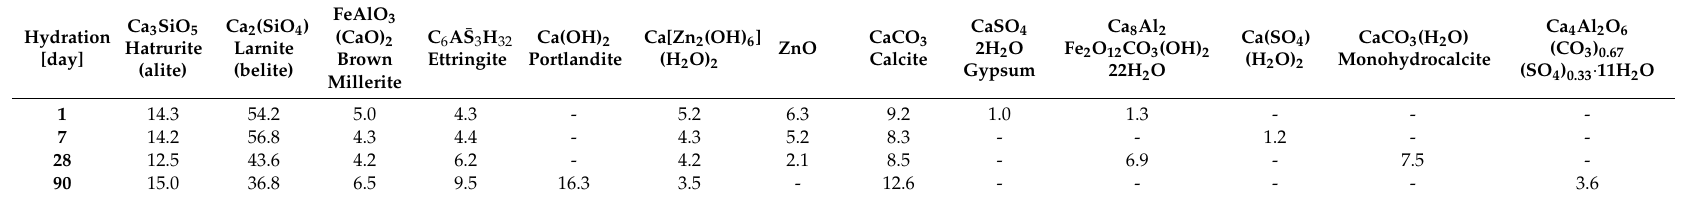
Table 6. Mineral composition of sample with